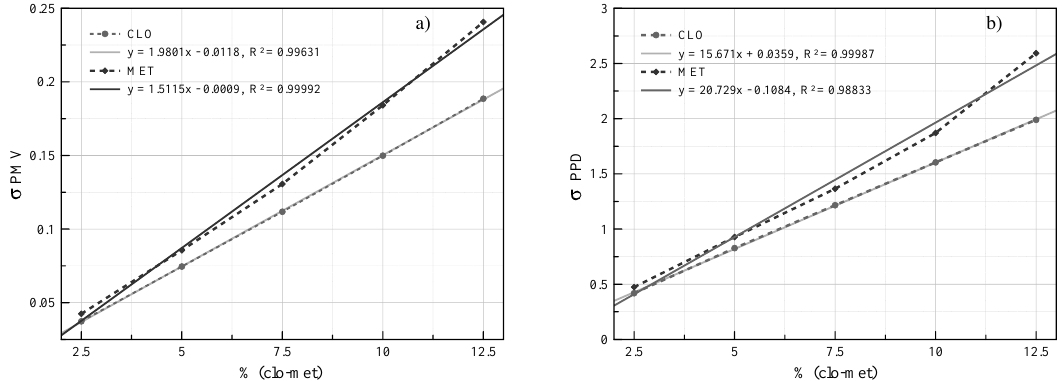
Figure 6. Association between variations of clothing and activity with the widths of ( a ) σ PMV ( b ) σ PPD